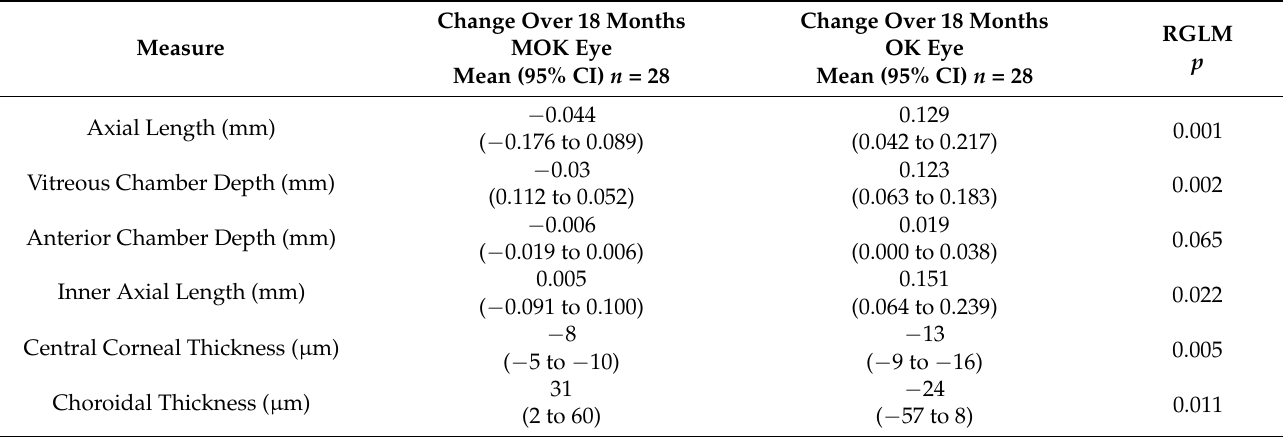
Table 2. Comparison of the effects of 18 months of MOK and OK lens wear on ocular structures. Changes over 18 months for eyes wearing MOK lenses and those wearing OK lenses. There was significantly less elongation of axial length, vitreous chamber depth, and inner axial length in MOK eyes than OK eyes. The central corneal thickness thinned significantly less in MOK eyes, but choroidal thickness increased significantly more in MOK eyes than in OK